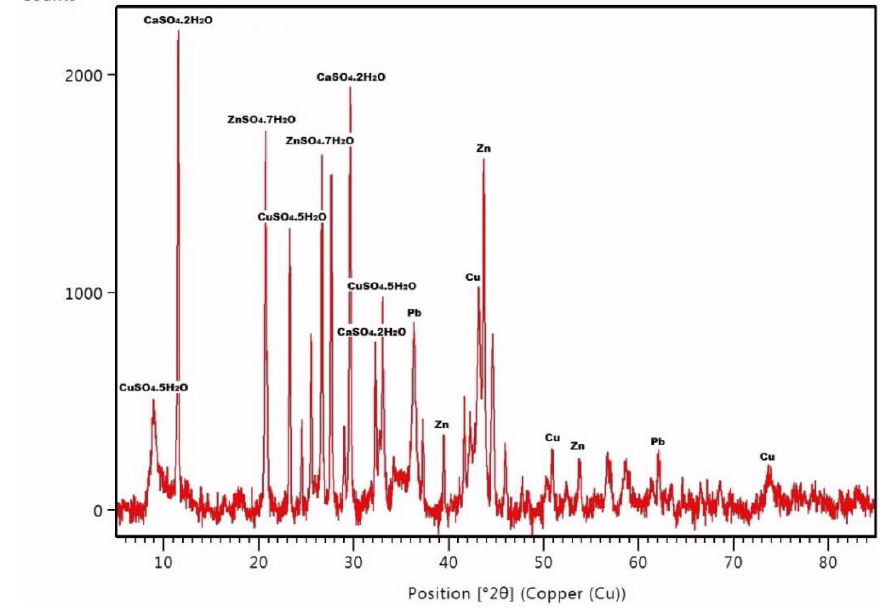
Figure 4. XRD powder pattern of the CEZinc ZPR.